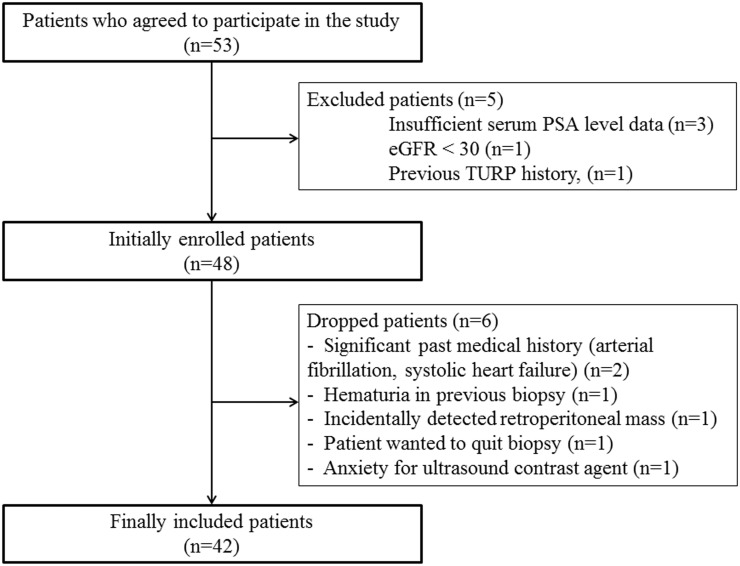
Flow chart of the patient enrollment.